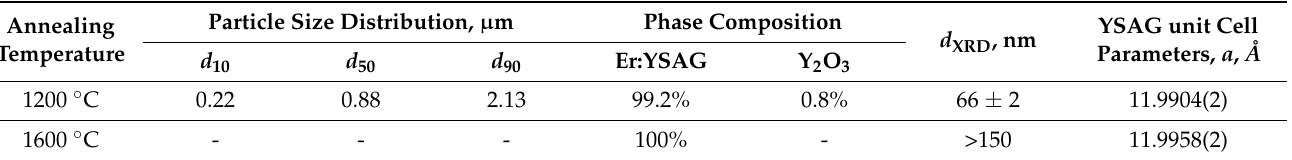
Table 1. Characteristics of the Er 3+ :YSAG ceramic powder obtained with calcinations at 1200 ◦ C and 1600 ◦